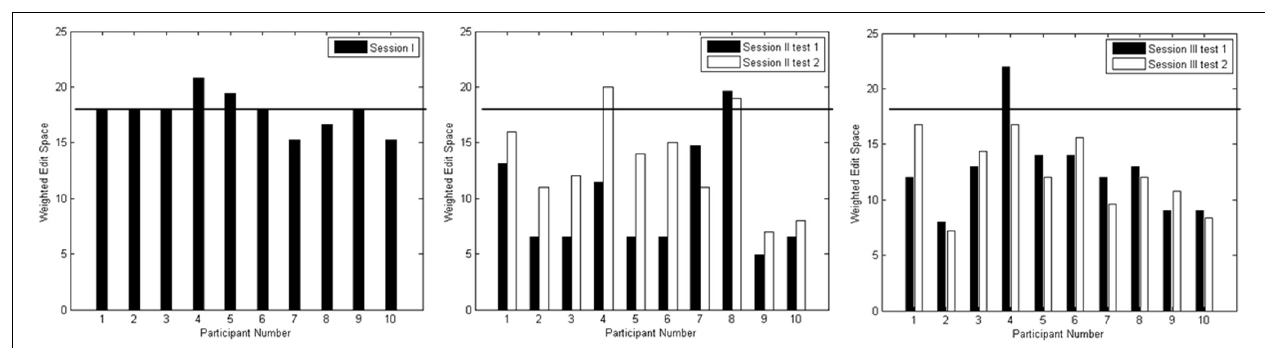
FIGURE 8 | Edit distances for test blocks from Sessions I (left plot), II (middle plot) and III (right plot). The horizontal line on each graph indicates an edit distance of 18 where no input was observed.